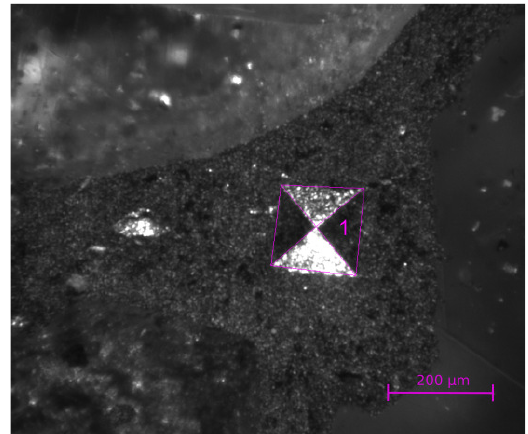
Figure 3. Right: Marked area of the imprint obtained by semi–automatic evaluation method.